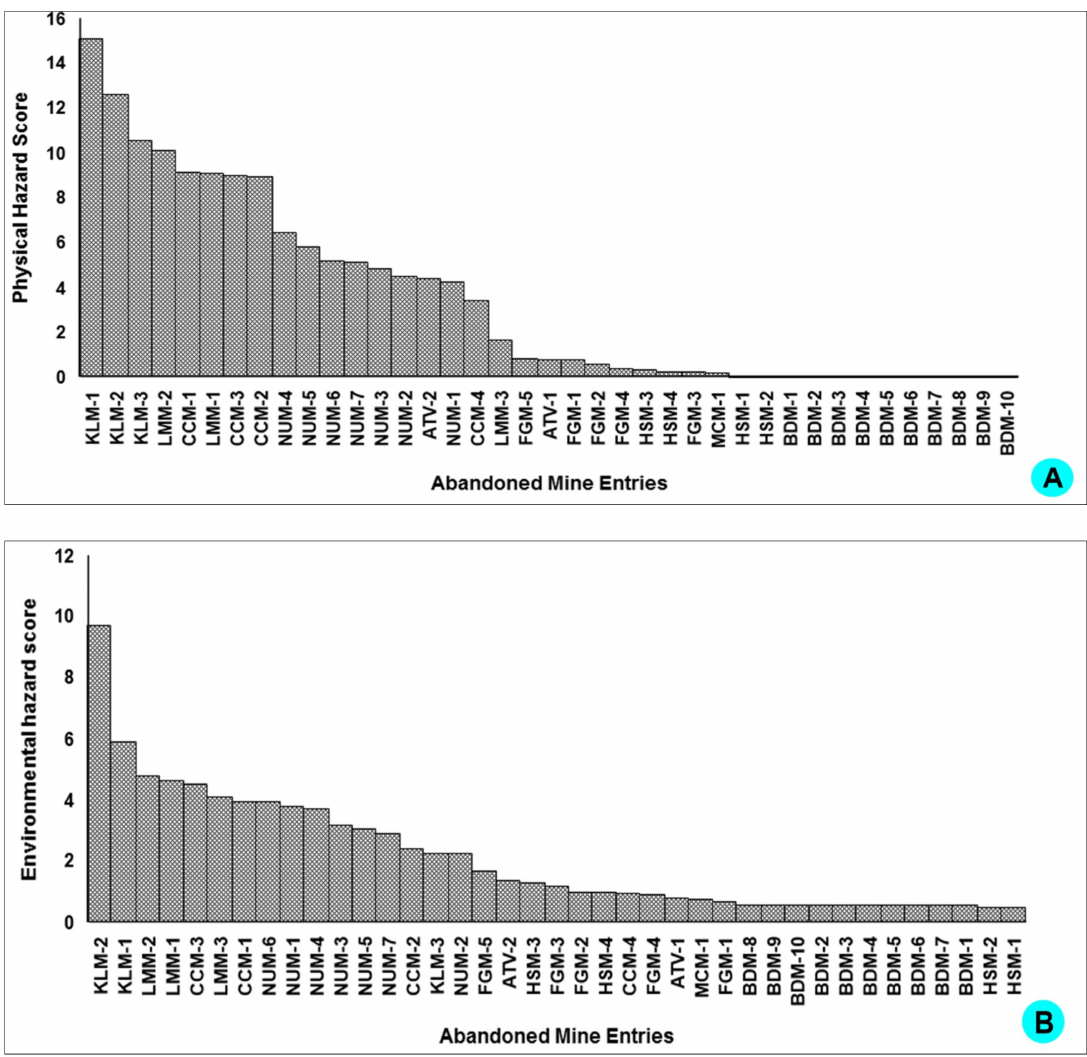
Figure 6. The physical ( A ) and environmental ( B ) hazards scores of the mine entries in the Giyani and Musina